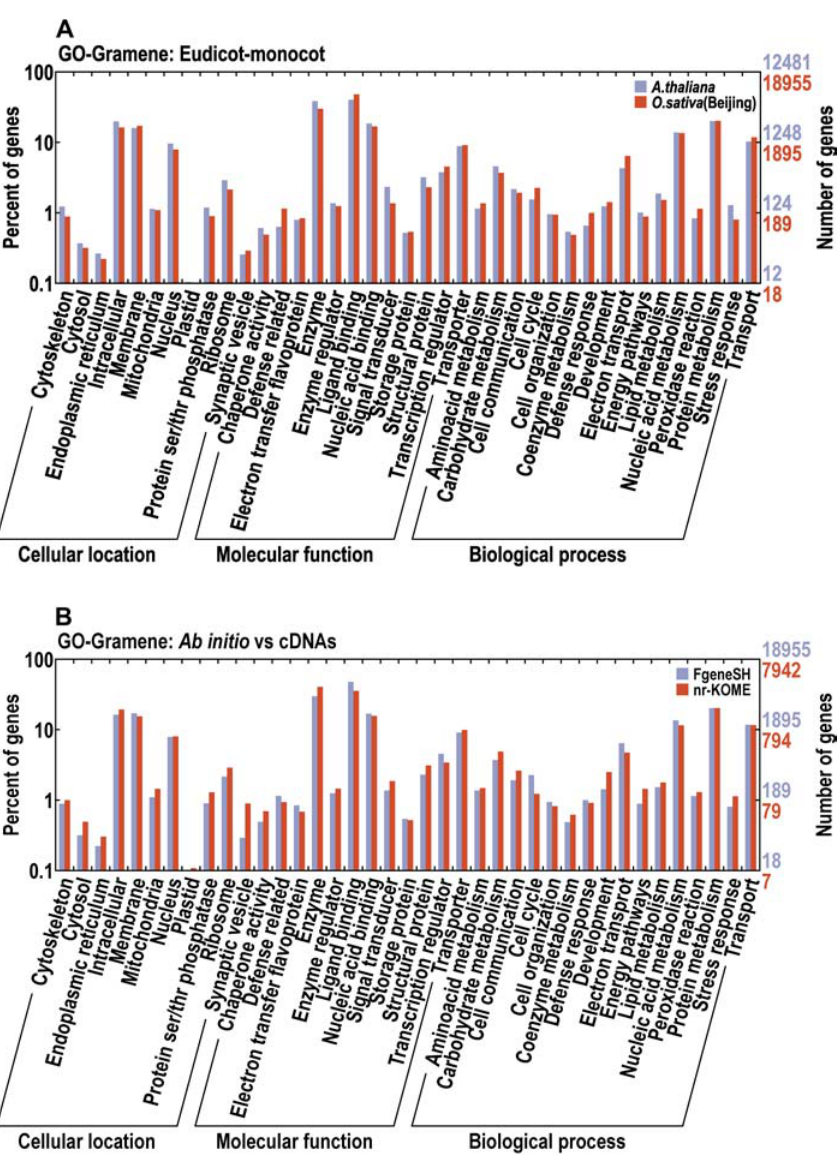
Figure 4. Functional Classifications from GO, Focused on Plant-Specific Categories Outlined by Gramene (A) compares predicted genes from Arabidopsis and Beijing indica . (B) compares predicted genes from Beijing indica with nr-KOME cDNAs. We ignore categories with less than 0.1% of the genes. DOI: